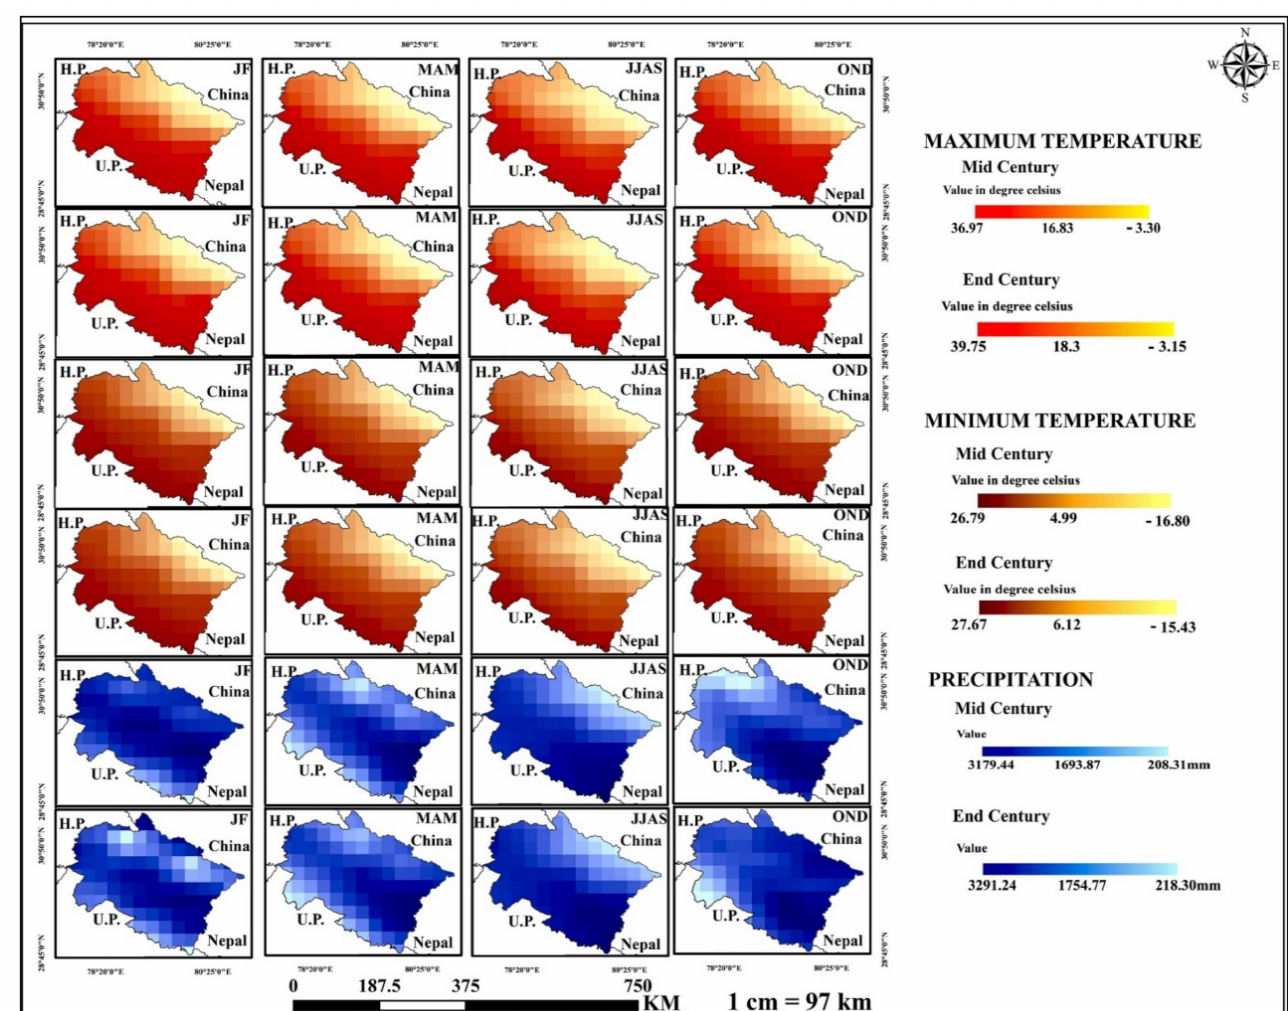
Figure 6. Projected spatial representation of seasonal (JF, MAM, JJAS, and OND) precipitation and temperature (maximum & minimum) from MC to EC for the multimodel ensemble RCM (RCP